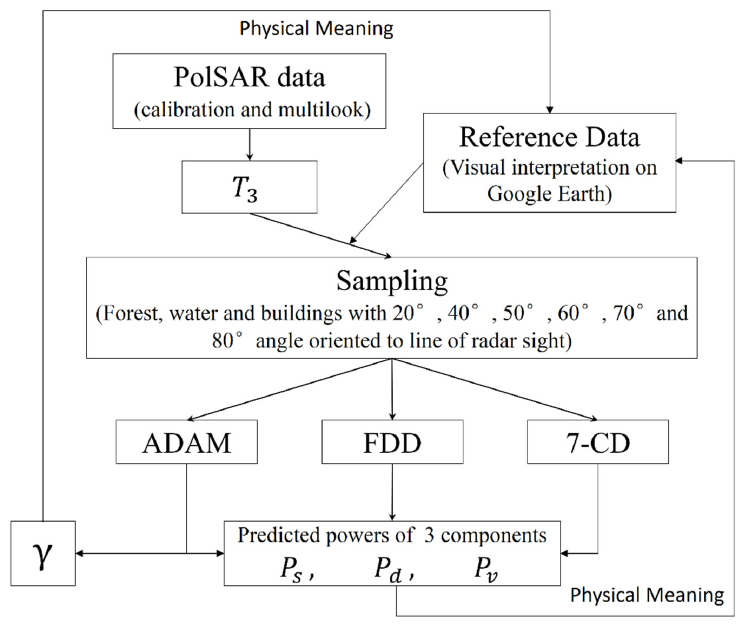
Figure 6. The experimental scheme to evaluate ADAM on space-borne PolSAR data.